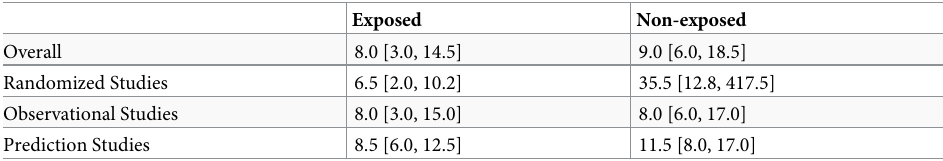
Table 2. Descriptive statistics for number of citations. Estimates show the median